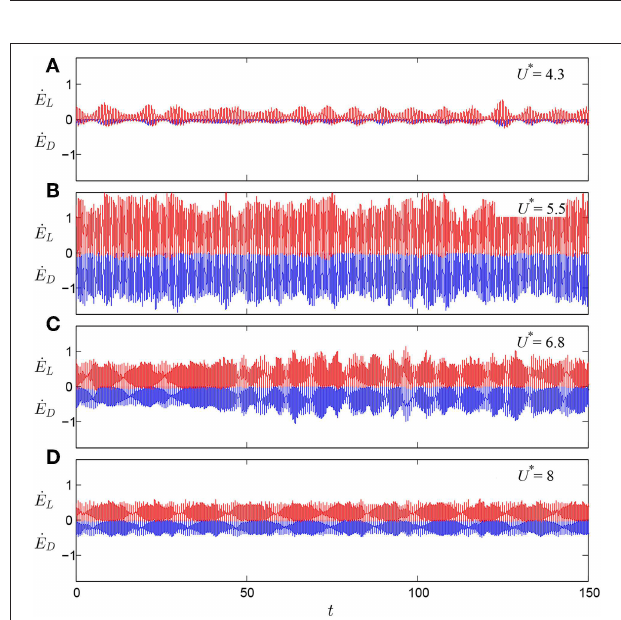
4.3, (B) U ∗ 5.5, (C) U ∗ = = =